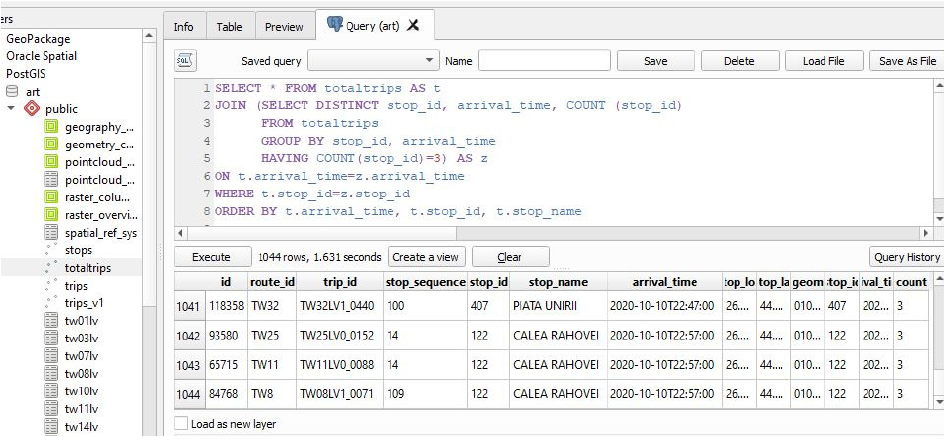
Figure 13. Example of 3 vehicles arriving at the stop_id 122 at the same time.